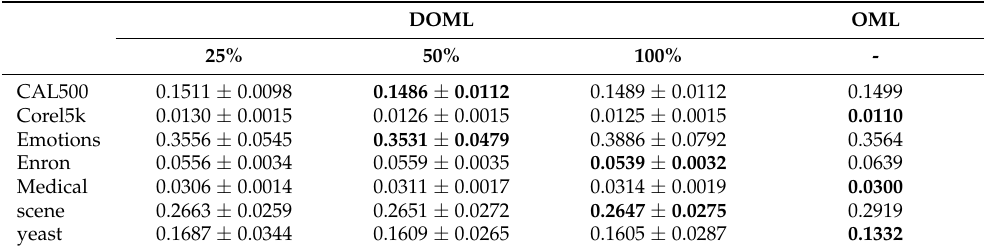
Table 5. Hamming loss of DOML in a 20-node network with different connectivity and OML with the same amount of instances as each